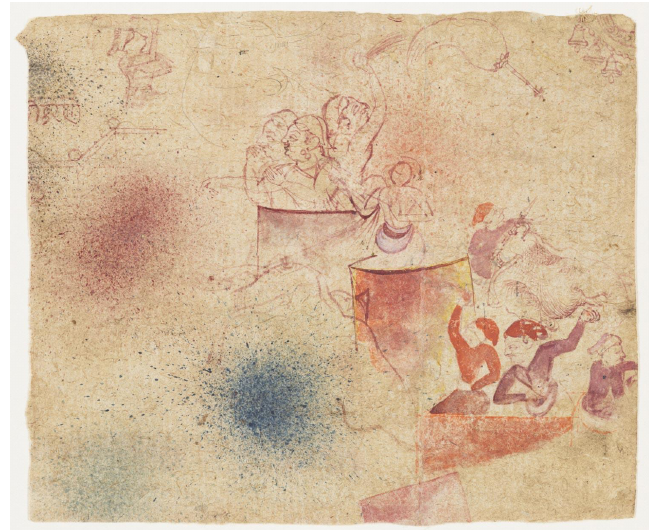
Figure 9 Figure 9. Artist unknown, “Noblemen on Elephant during Holi Festival”, brush and red and black